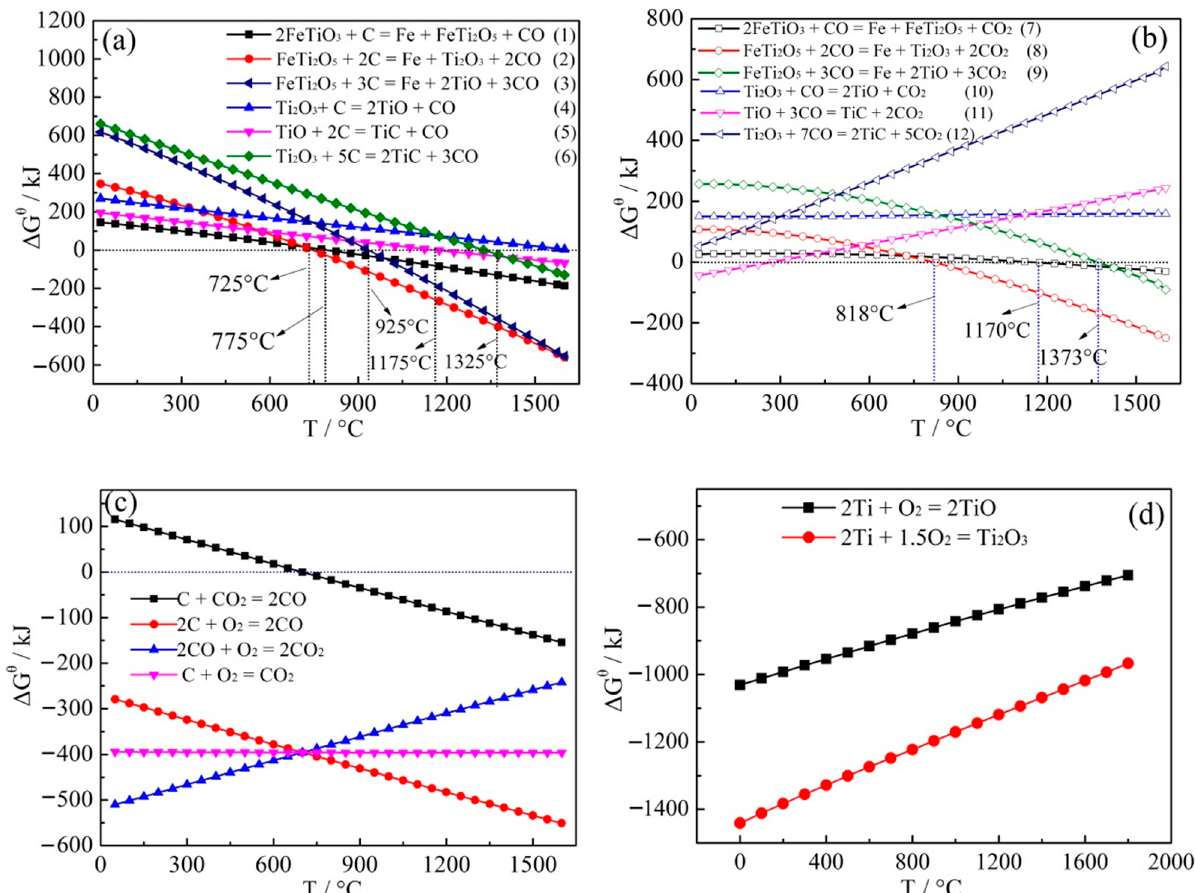
Figure 9. Correlation of Δ G θ with temperature. ( a ) Δ G θ − T for Equations (1)–(6); ( b ) Δ G θ − T for Equations (7)–(12); ( c ) Δ G θ − T for carbon system; ( d ) Δ G θ − T for TiO and Ti 2 O 3 .